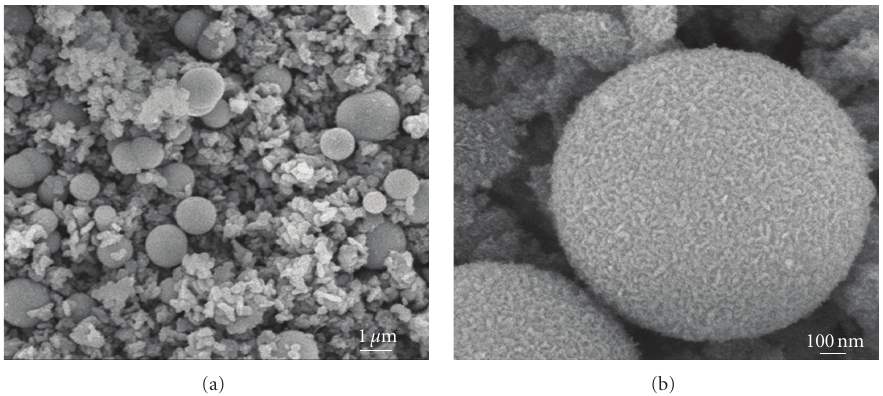
Figure 2: SEM images of the as-prepared TiO 2 : (a) low magnification, (b) high magnification.